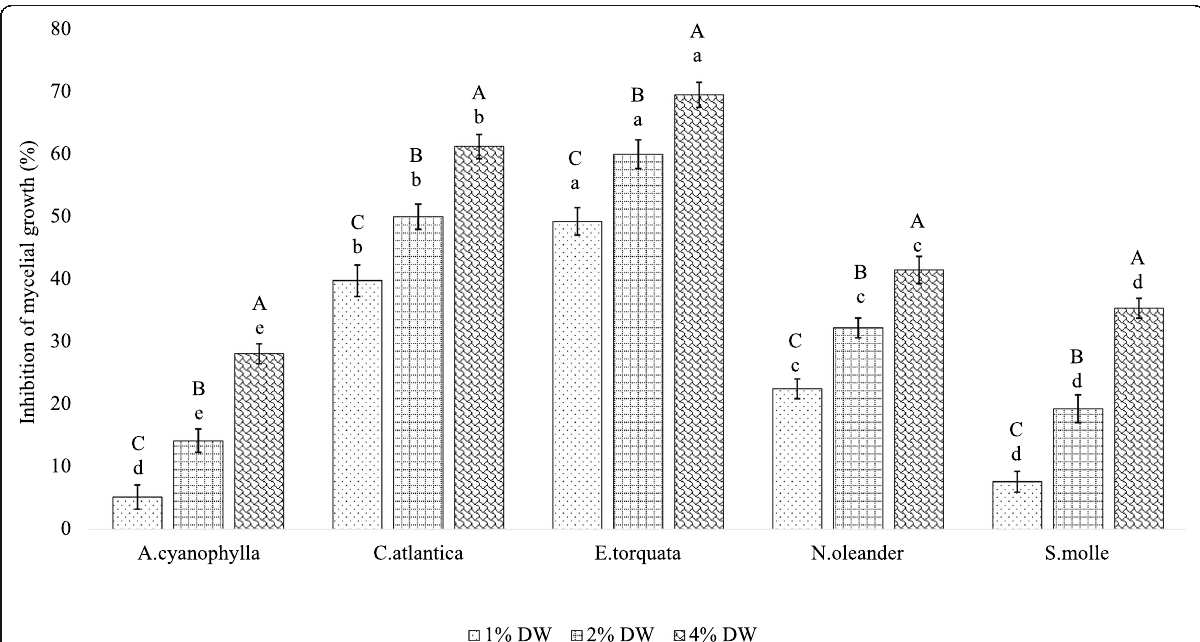
Fig. 1 Effect of different plant DW percentage on Foa mycelial growth. Plant species and extract concentration had significant effects on the percentage of radial growth inhibition (one-way ANOVA, p < 0.05). Each bar represents the mean of five replicate plates per concentration. Within each plant species, bars followed by the same uppercase letters indicate no significant differences among extract concentrations, while within each concentration; bars followed by the same lowercase letters indicate no significant differences among plant species (Bonferroni tests, p < 0.05). Error bars represent standard